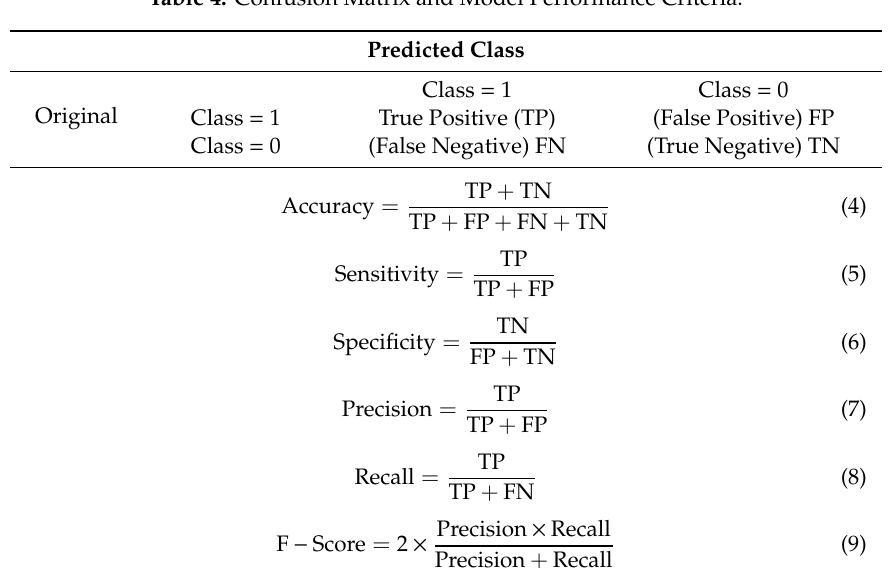
Table 4. Confusion Matrix and Model Performance